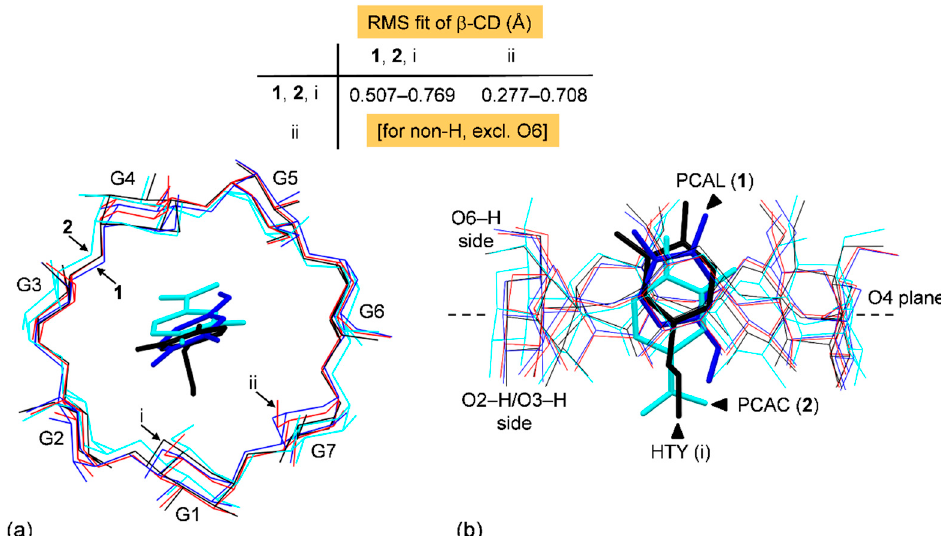
Figure 2. Radar plots comparing ( a ) tilt angles and ( b ) O3( n )···O2( n + 1) distances of the β -CD glucose units (G1–G7) influ- enced by the inclusion of PCAL ( 1 ), PCAC ( 2 ) and HTY [35]. For comparison, data of the inclusion complexes of β -CD–(– )-epicatechin(EC) [43] and the uncomplexed β -CD·12H 2 O [42] are incorporated; see also Table S2. Angles and distances are in ° and Å.